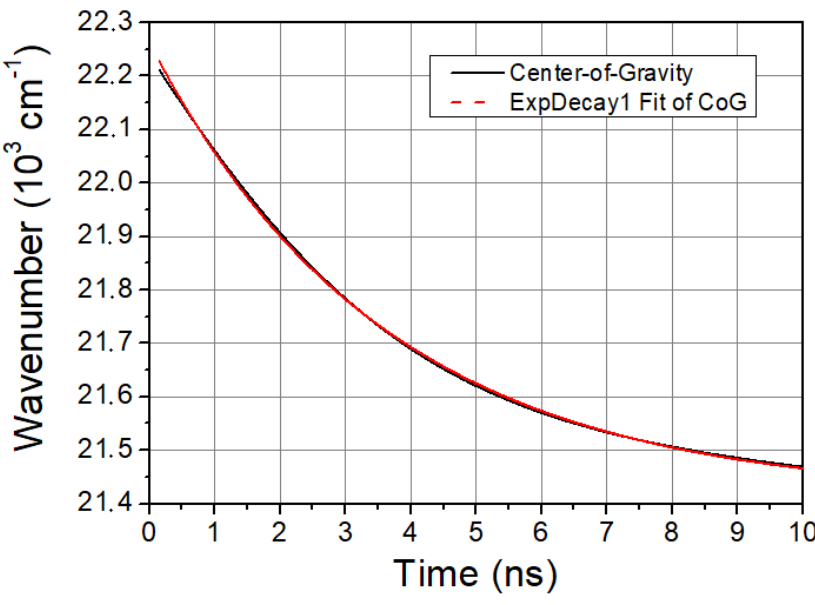
Figure 2. CoG function of LAURDAN. Black line is the CoG function of LAURDAN and red dashed line is a mono-exponential fit giving excellent cover with the measured CoG function.